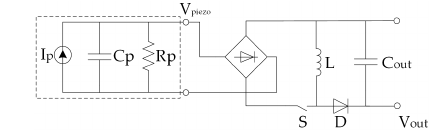
Figure 48. The SECE rectifier circuit.